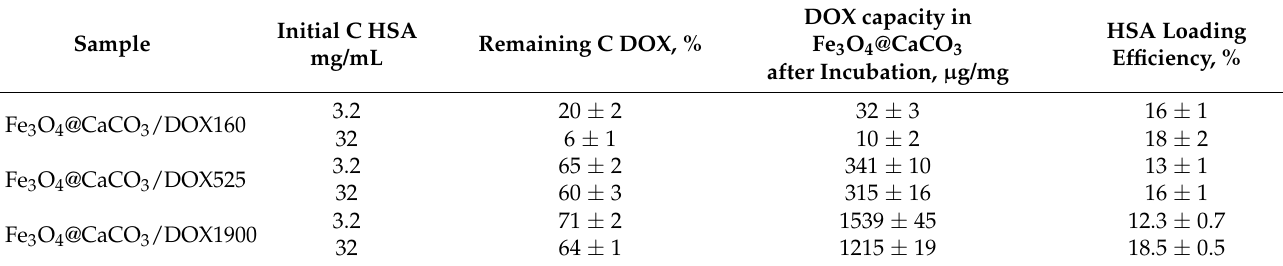
Table 5. HSA loading on Fe 3 O 4 @CaCO 3 /DOX